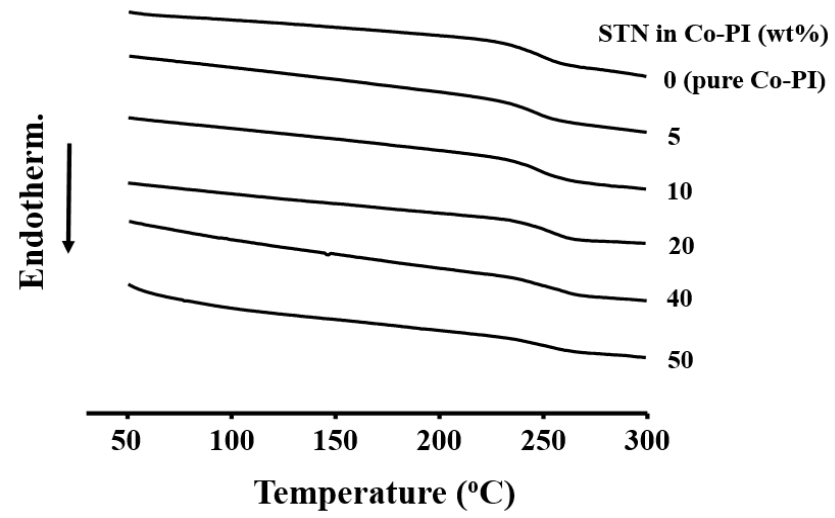
Figure 8. Differential scanning colorimetry (DSC) thermograms of the Co-PI hybrids with various STN concentrations.